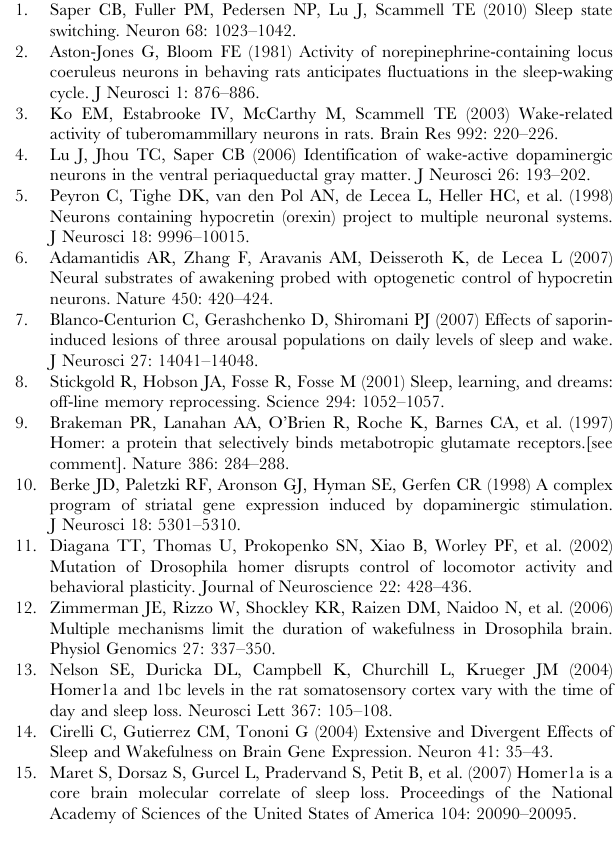
Table S2 Average amount of REM and REM bout duration for Homer 1a wildtype, heterozygote and knockout mice measured in 2 hour time periods. Values are given for the average plus/minus